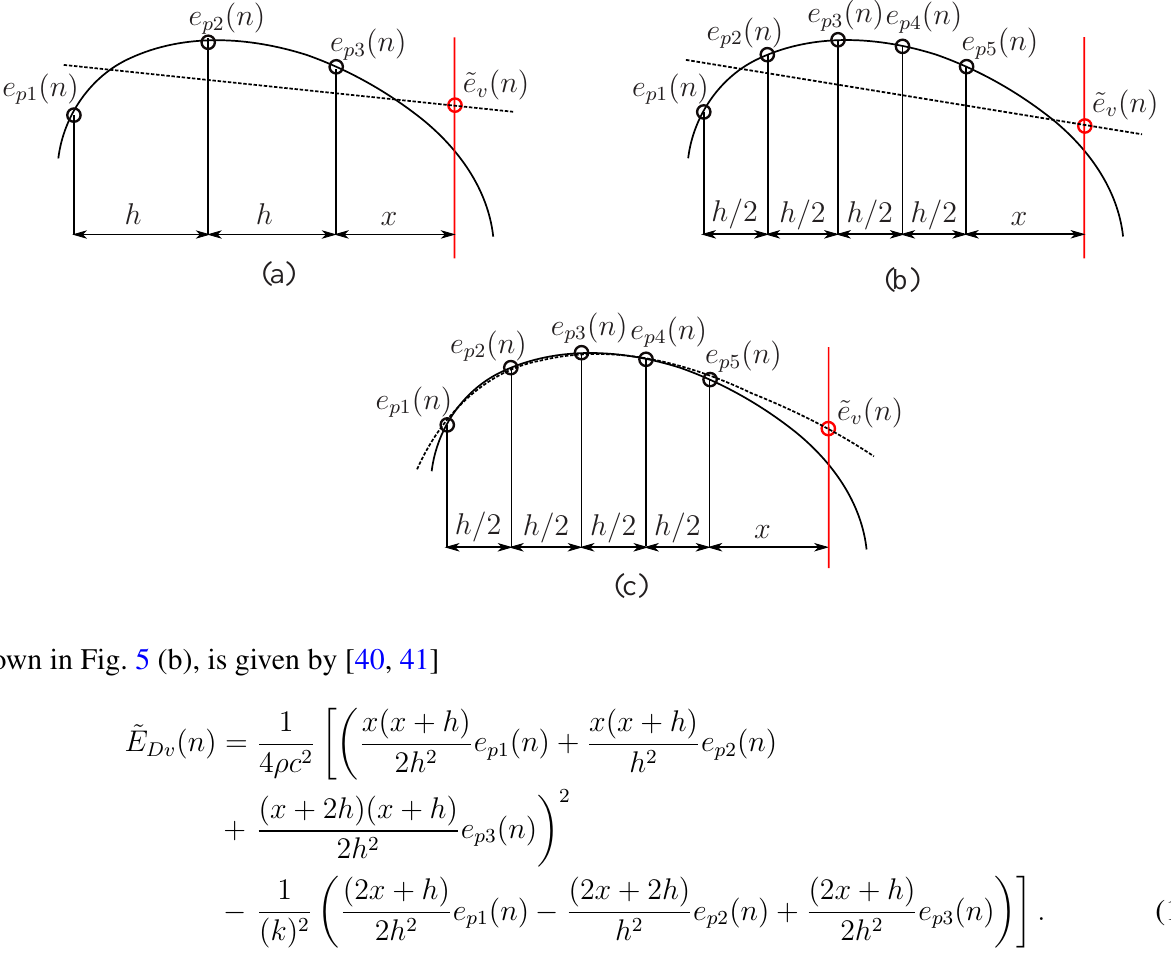
Figure 6. Diagram of (a) three microphone linear forward difference extrapolation; (b) five microphone linear forward difference extrapolation; and (c) five microphone quadratic forward difference extrapolation. The black curved line represents the actual pressure field and the dashed line represents the pressure estimate.